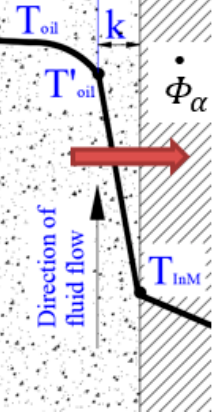
Figure 1. Fluid temperature distribution at the surface of the motor element, where k —thickness of the laminate boundary layer, T oil —temperature of the flowing oil, T oil ’ —oil temperature at the border of the boundary layer, T InM —temperature of the internal surface of the motor body.